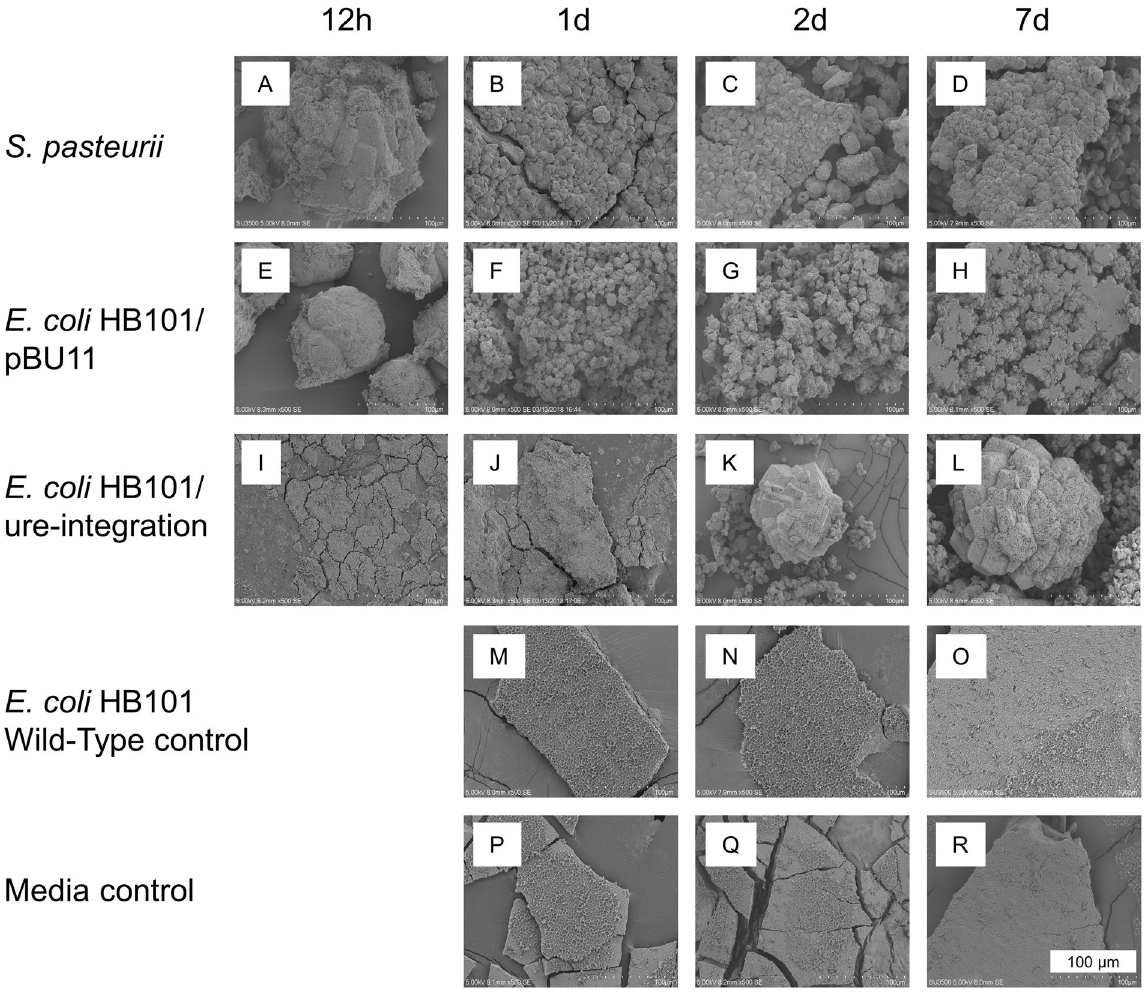
Figure 3. Longitudinal evolution of CaCO 3 morphology across 7d for engineered E. coli and control comparisons. S. pasteurii ( A–D ) and E. coli HB101/pBU11 ( E–H ) both had an evolution over time from large, poorly faceted structures at 12h to smaller, faceted polycrystalline structures with abundant bacterial casting at 1–7d. E. coli HB101/ure-integration ( I–L ) initially formed calcium phosphate nanocrystals until 2d, when large, round, highly casted CaCO 3 crystal structures appeared. At 7d, the average calcite crystal size was smallest for E. coli HB101/pBU11, followed by S. pasteurii and then E. coli HB101/ure-integration. Wild-Type ( M–O ) and Media ( P–R ) controls produced only calcium phosphate nanocrystalline sheets which did not vary in morphology from 1–7d. All SEM images shown at 500 ×